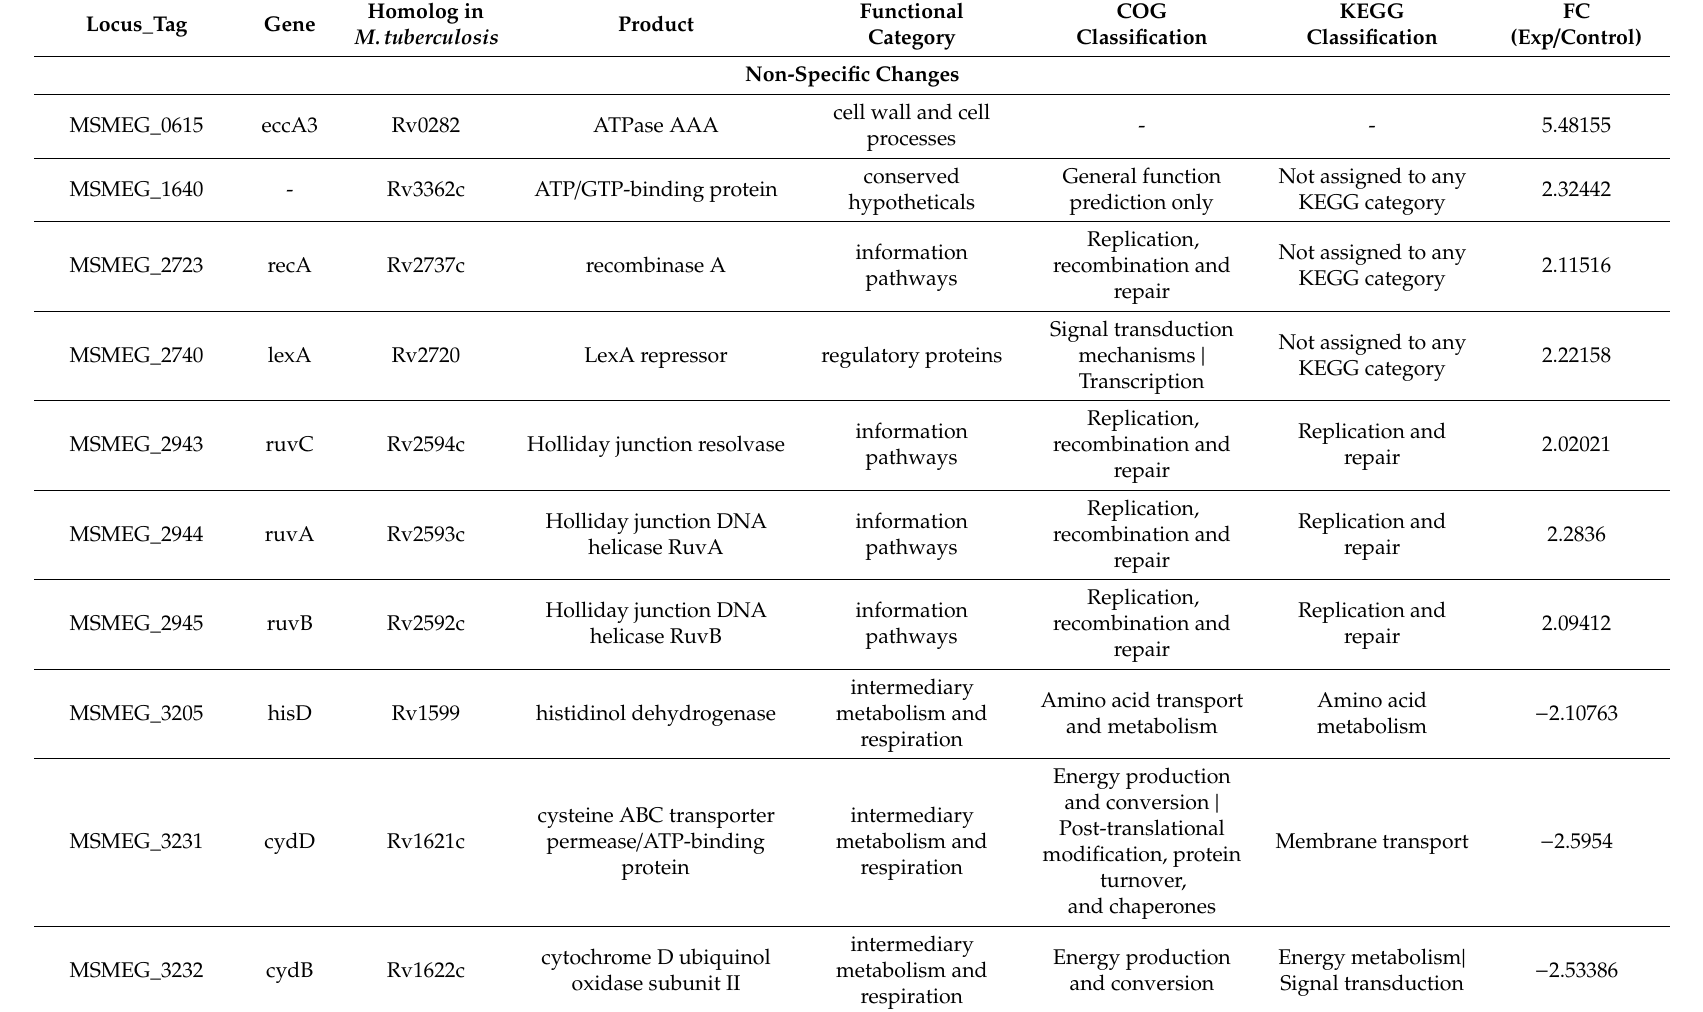
Table 2. Changes of M. smegmatis in response to Olivomycin A discussed in the